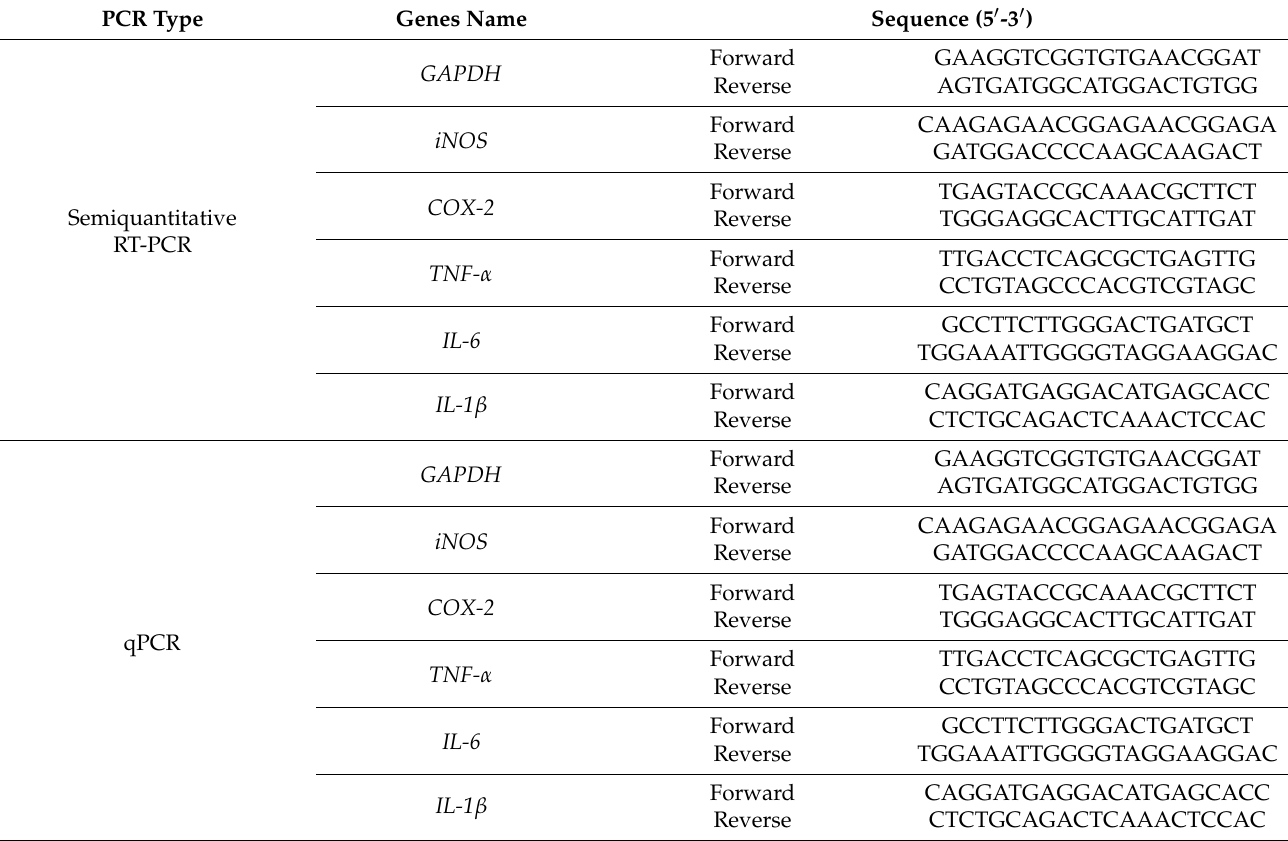
Table 1. Primer sequences used for